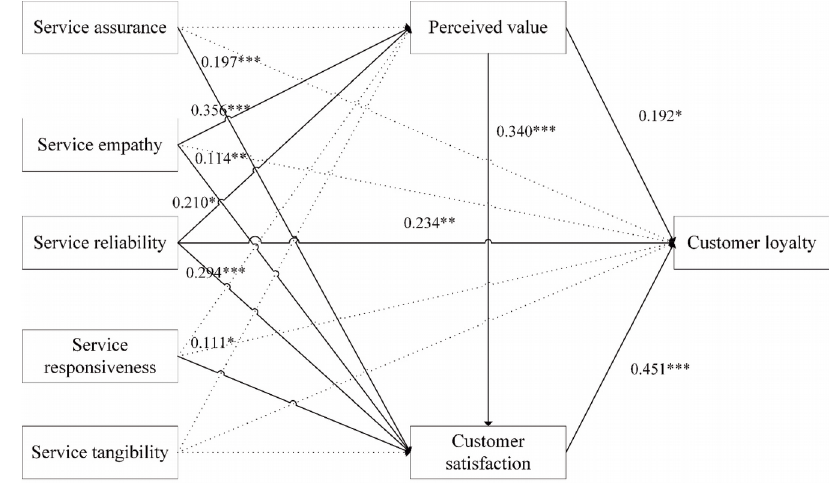
Figure 4. PLS-MGA result of structural equation model for